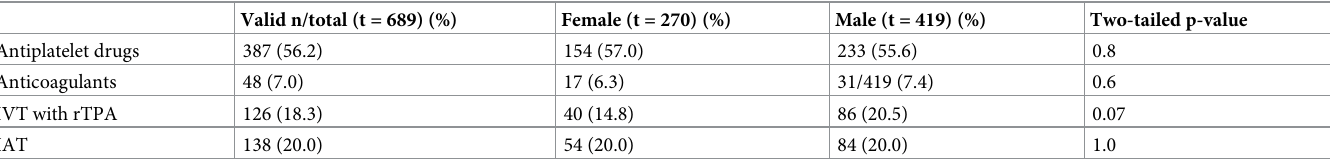
Table 2. Treatment procedures according to